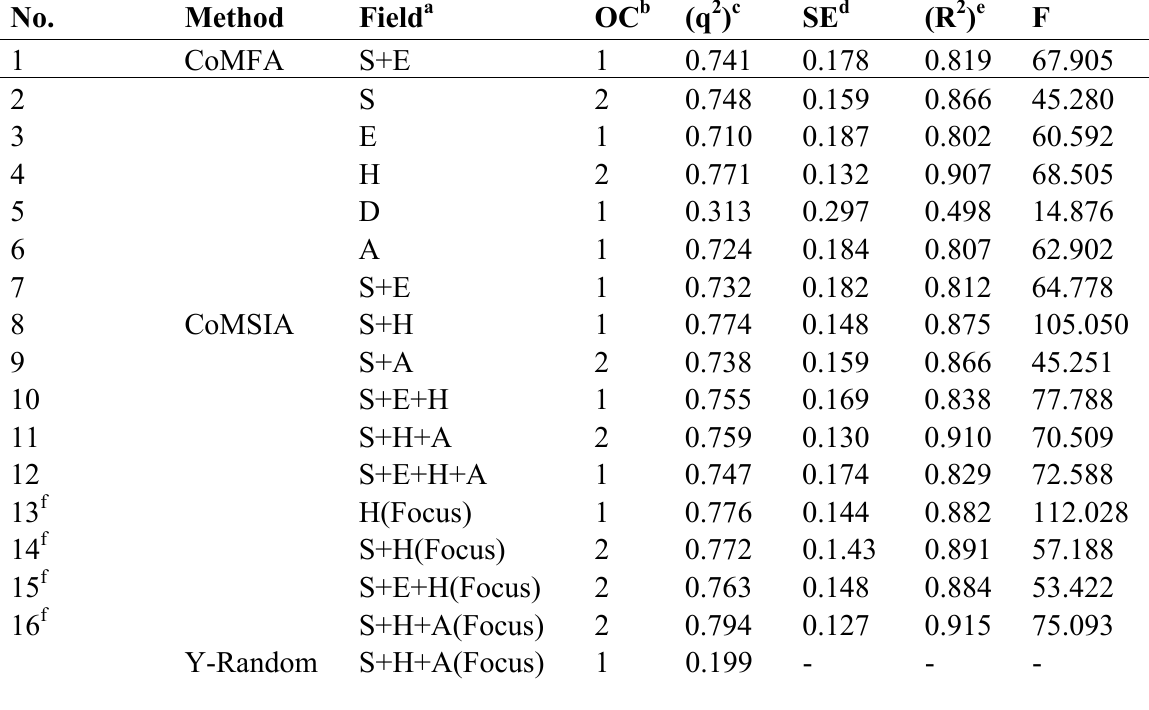
Table 2. Comparison of different 3D-QSAR